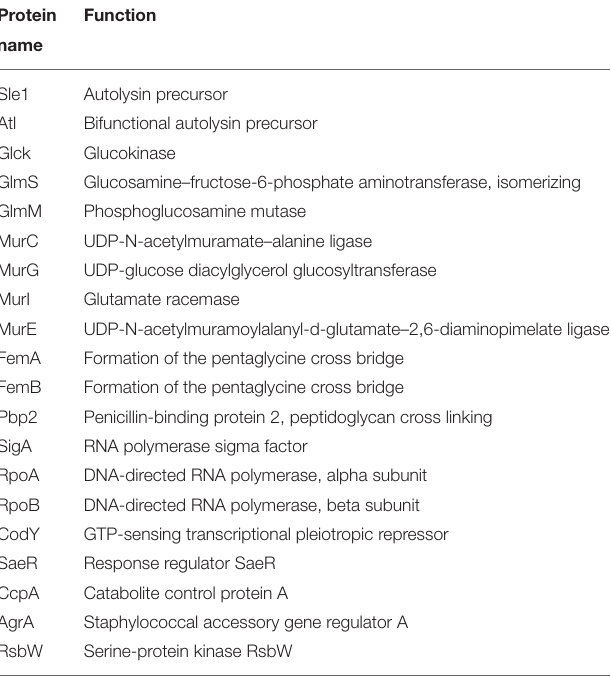
TABLE 4 | Summary of ClpP or ClpC substrates related to vancomycin resistance in VISA.